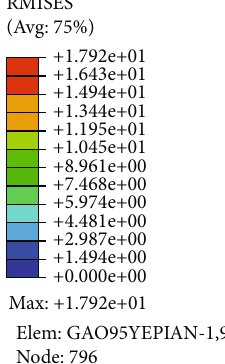
Figure 5: Campbell diagram.